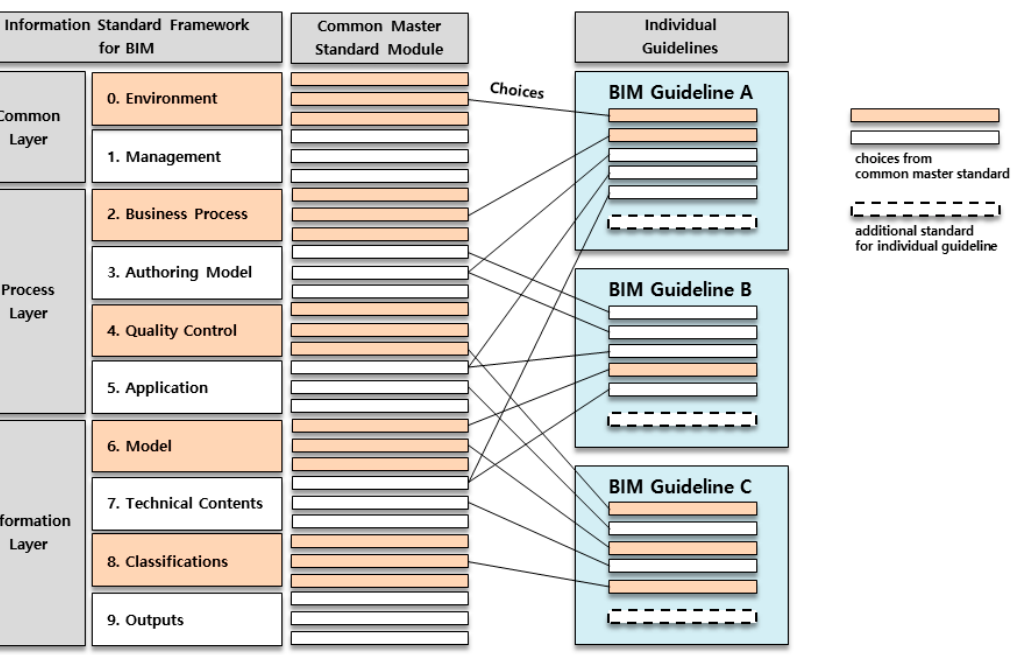
Figure 5. Relationship between Common Master Standards and Individual Guidelines.